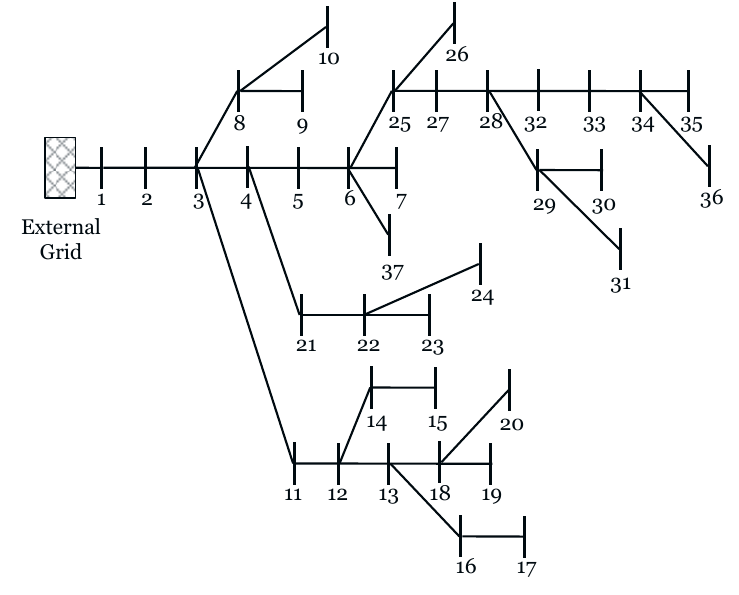
Figure 6. IEEE 37 node